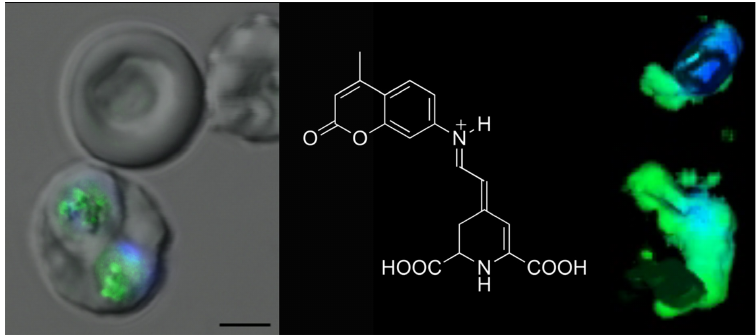
Figure 5 - An example of live cell imaging of Plasmodium -infected red blood cells with cBeet120 (molecular structure indicated in the figure). The blue and green fluorescence emissions are from Hoescht 33342 (a selective stain for DNA) and cBeet120,